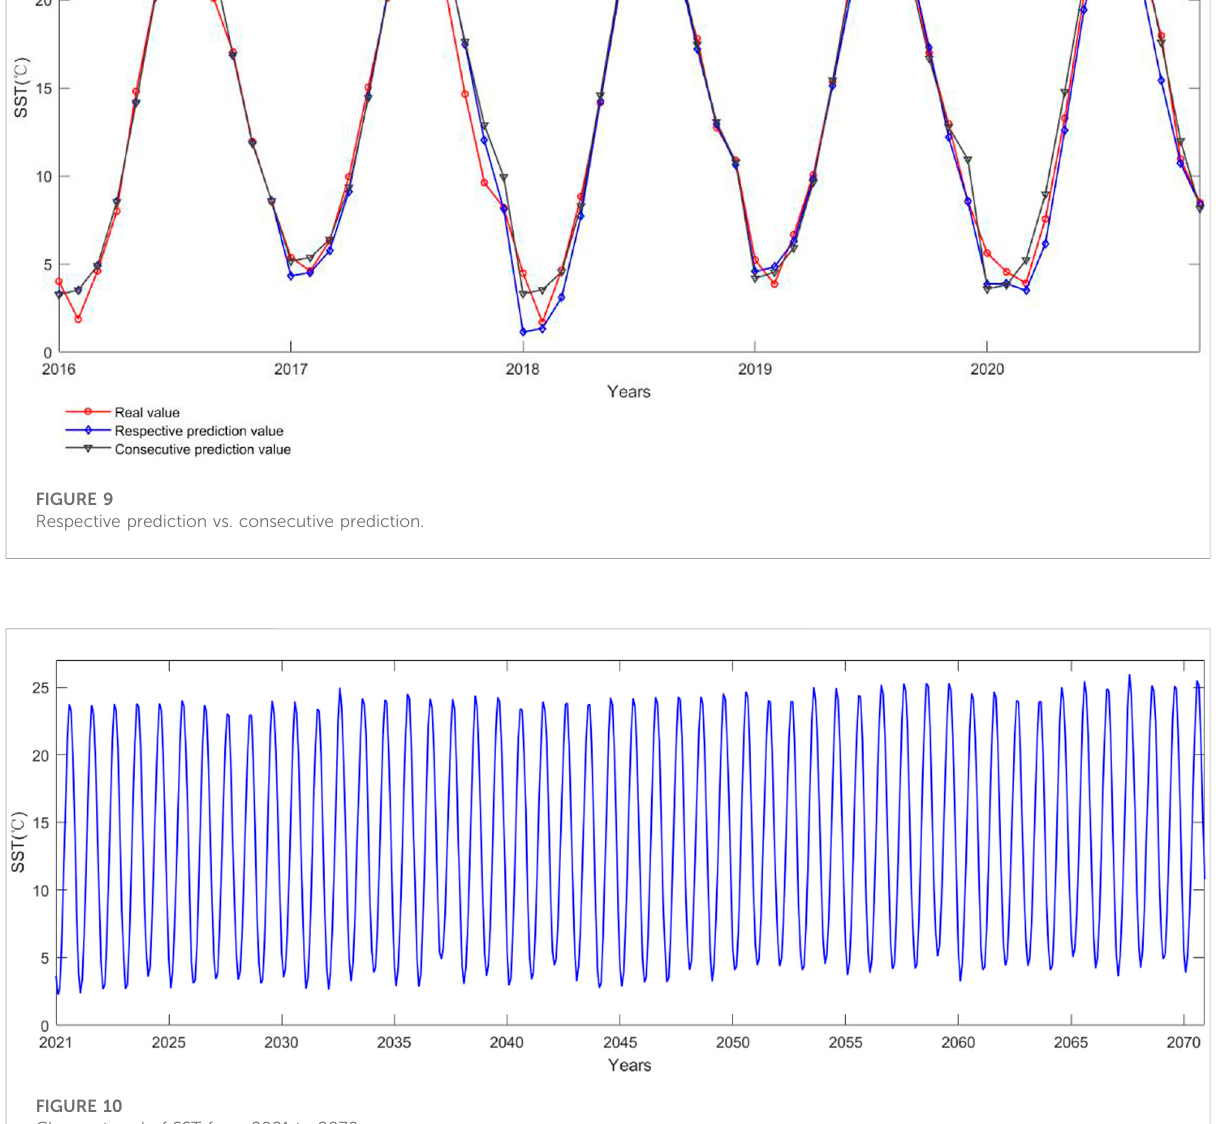
FIGURE 10 Change trend of SST from 2021 to